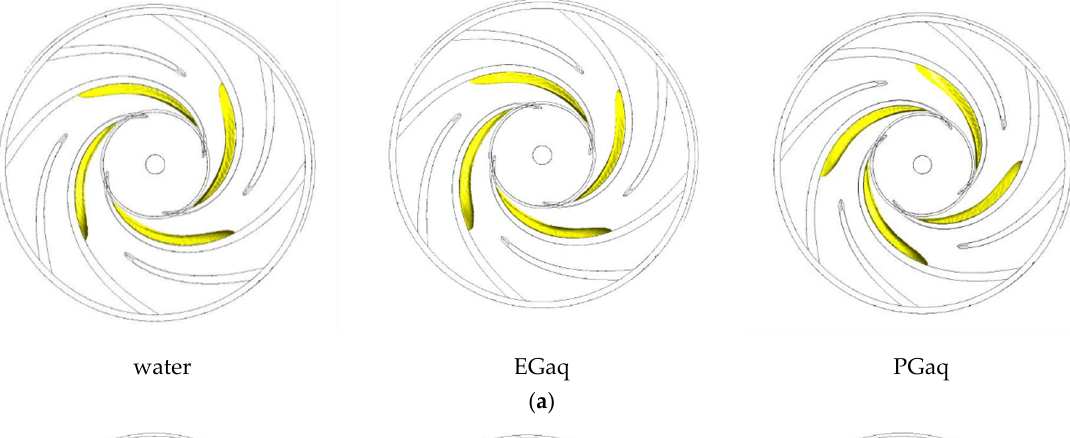
Figure 19. Iso-surface of cavitation distribution in the impeller of splitter blades. ( a ) 20 °C at 0.3 atm; ( b ) 60 °C at 0.3 atm